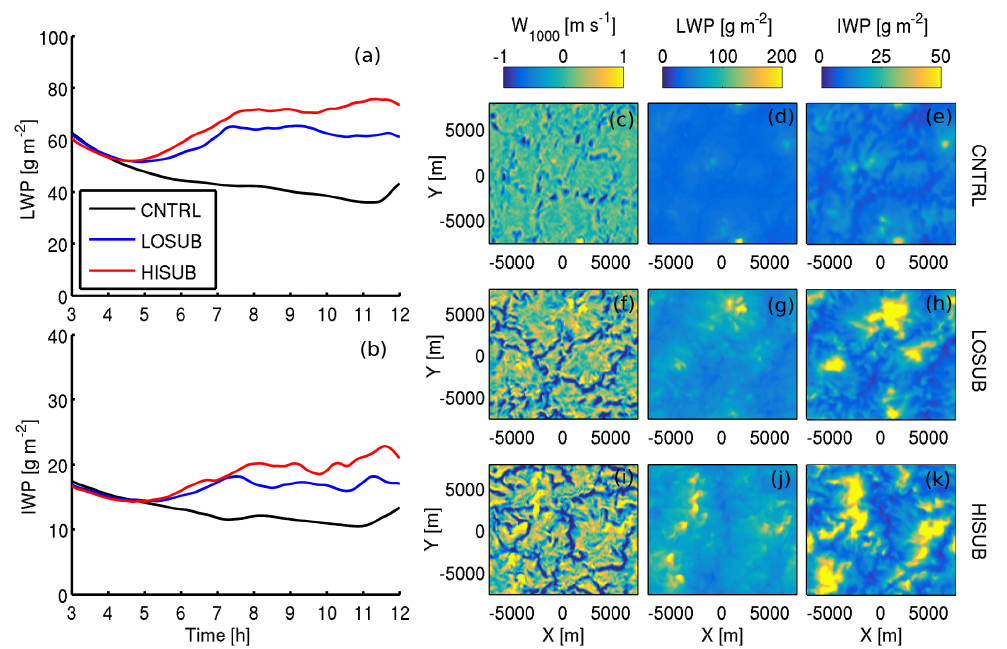
Figure 2. (a, b) Time series of the domain-averaged LWP and IWP from simulations imposing different magnitudes of large-scale subsidence. Black: control cases; blue: low W sub (LOSUB); red: high W sub (HISUB). (c–k) Planar X – Y views of (c, f, j) vertical velocity at 1000m ( W 1000 ), (d, g, j) LWP, and (e, h, k) IWP. Planar views shown at